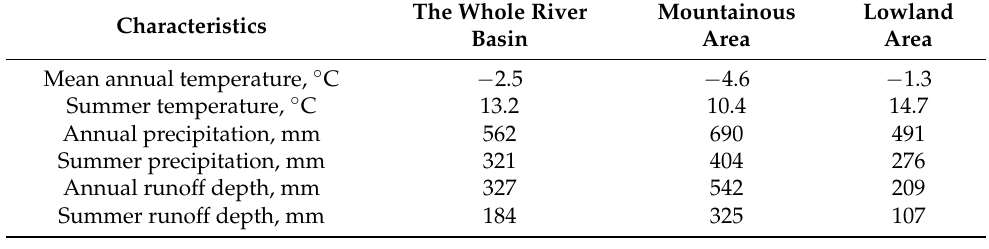
Table 2. Hydrometeorological characteristics of the Iya River basin over the period 1970–2019.